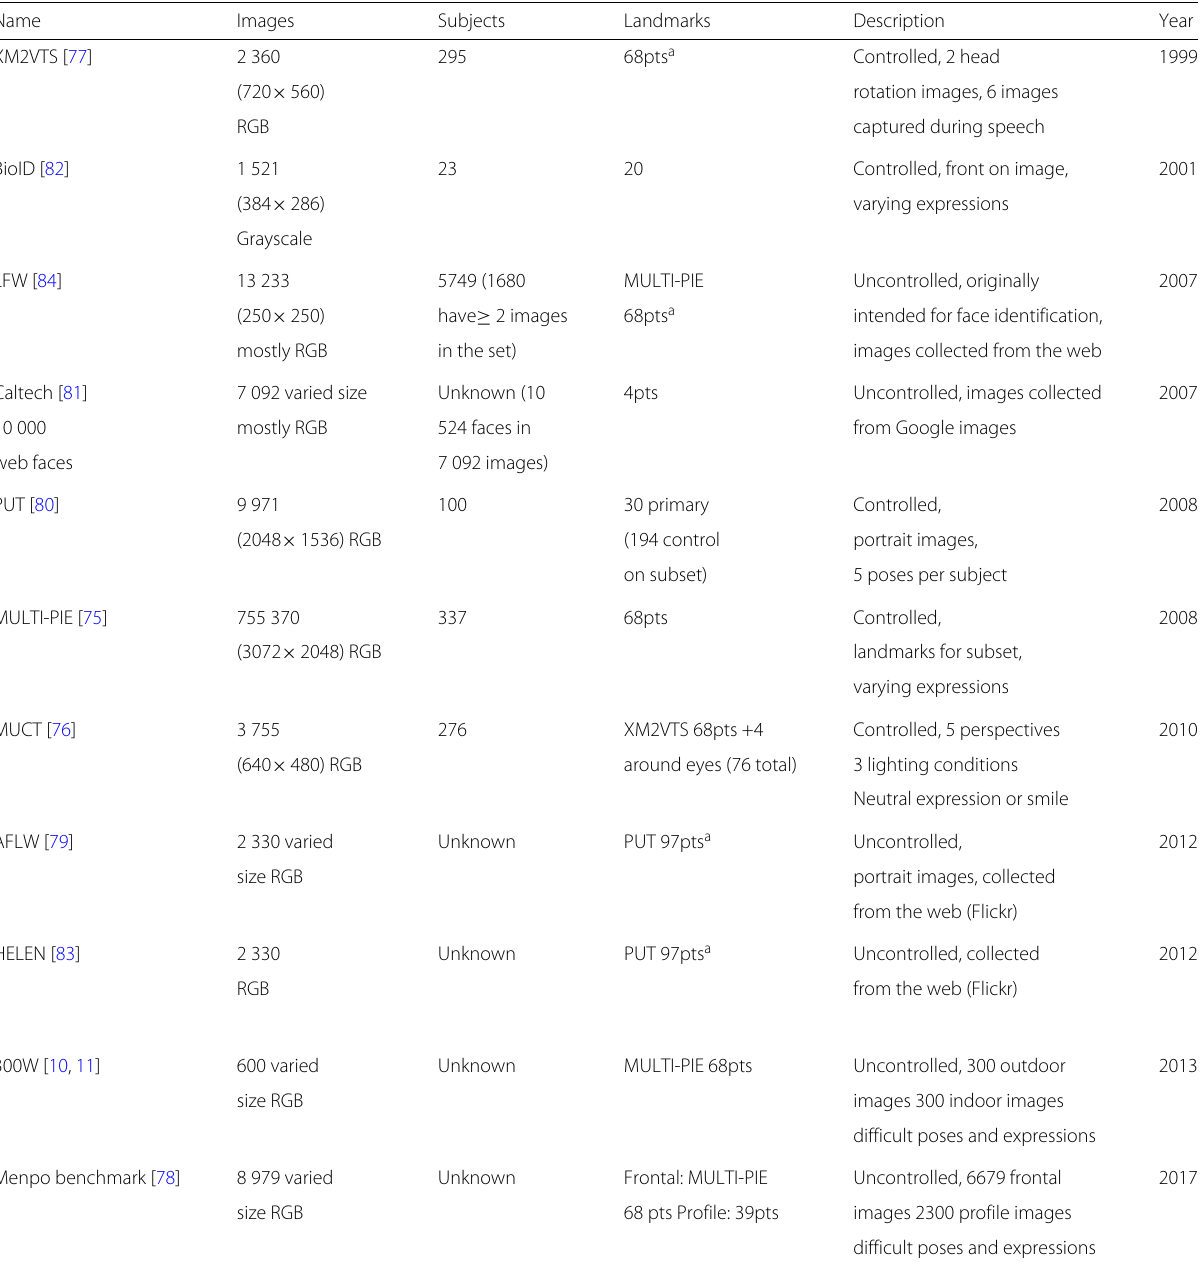
Table 1 Selection of publicly available facial landmarking